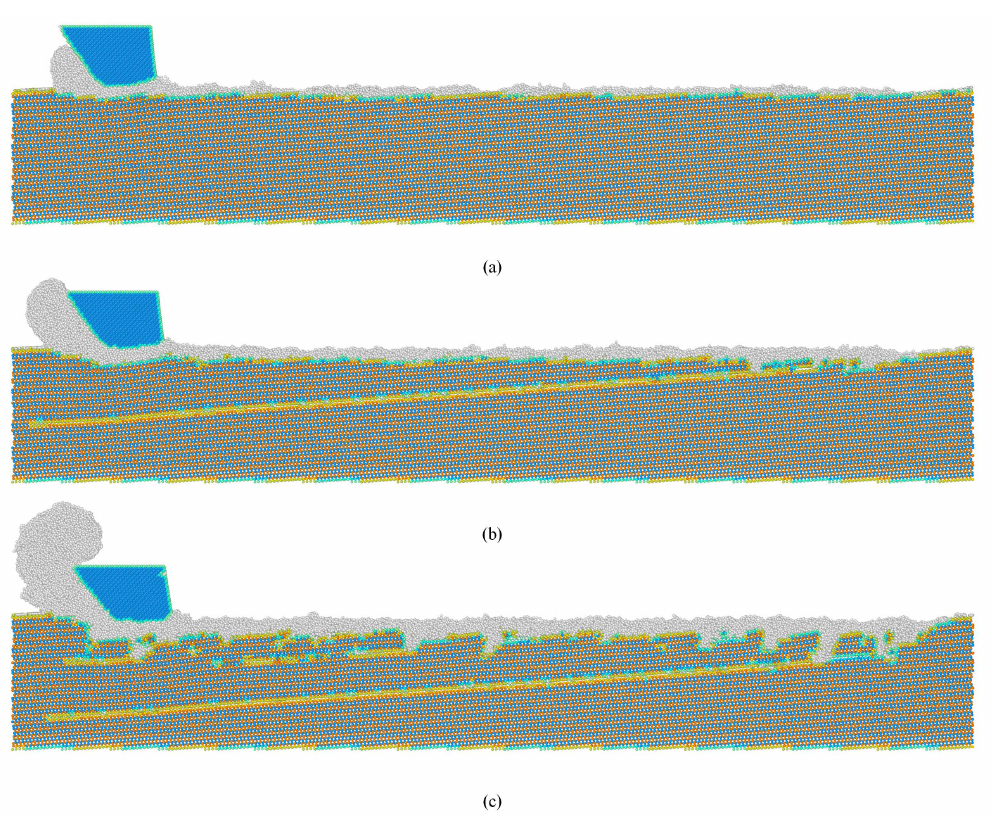
Figure 8. Structure transformation of the workpiece after cutting with different cutting